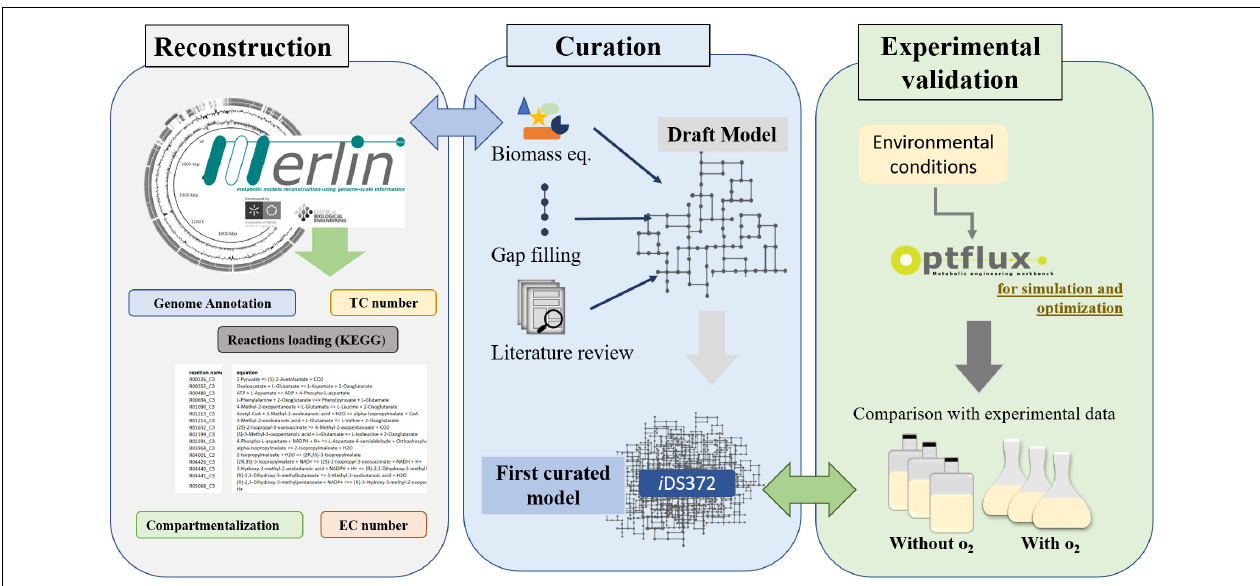
FIGURE 1 | Workflow for metabolic network reconstruction of S. pneumoniae R6 (EC, Enzyme Commission Number; TC, Transporter Classification). A draft of the network is reconstructed semi-automatically by merlin . The genome re-annotation, compartmentalization, and manual curation are performed using this user-friendly’s graphical user interfaces. Next, the biomass equation is formulated, resorting to available experimental data for S. pneumoniae R6 or closely related organisms (as determined via 16s rRNA analysis). Additionally, literature is also analyzed to improve the biomass equation. Environmental conditions, to mimic experimental data, are defined next. Using the software Optflux, simulations are performed using the model under the previously established environmental conditions. The simulated growth is compared to experimental data. If the results are distinct then the model is further reviewed and curated and the process is repeated until no significant differences exist between the experimental results and those obtained in silico